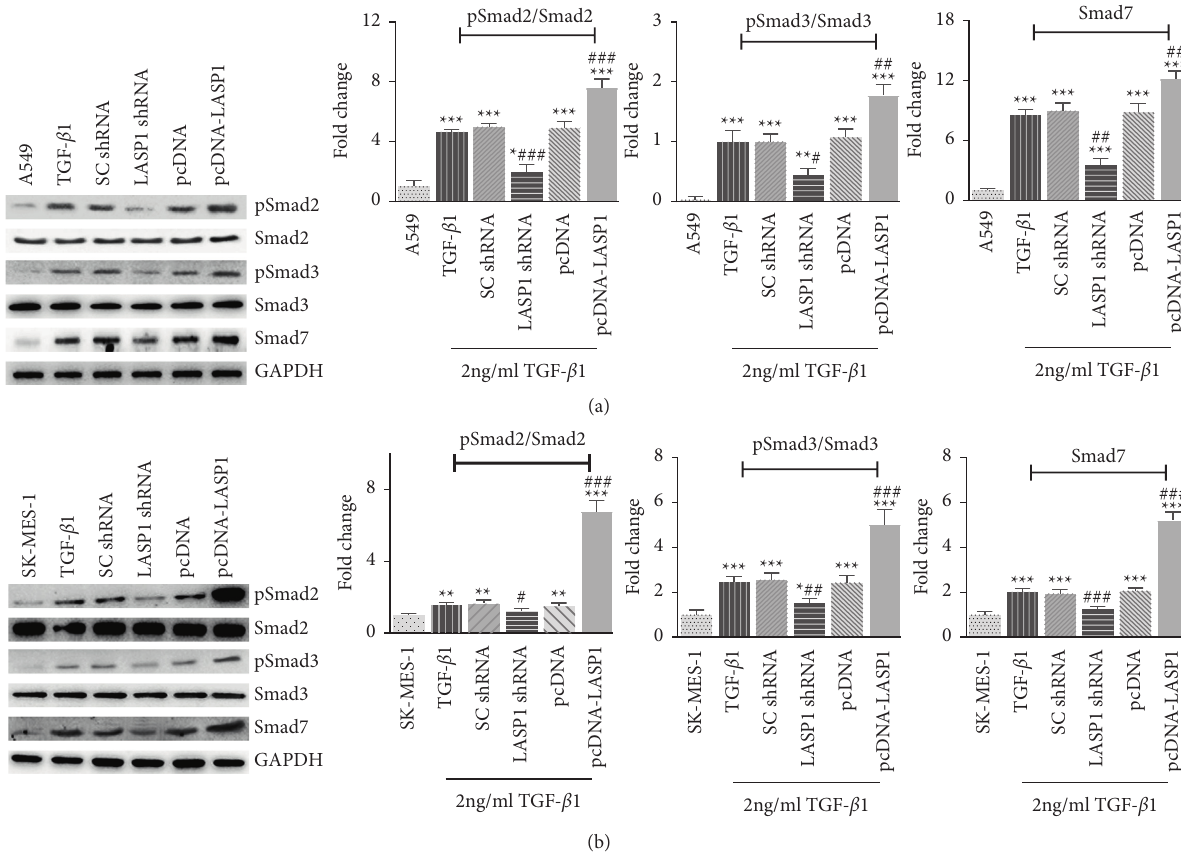
Figure 5: (a-b) LASP1 effect on key molecules in the TGF- β 1/Smad/Snail signaling pathway in A549 (a) and SK-MES-1 (b) cell lines under TGF- β 1 treatment. After 48 h coinfection with TGF- β 1 accompanying LASP1 knockdown or overexpression, the cell lysates were detected for protein levels of pSmad2, Smad2, pSmad3, Smad3, and Smad7 by western blot. Ratios of pSmad2/Smad2, pSmad3/Smad3 and Smad7/ GAPDH were presented by gray intensity analysis. GAPDH was used as reference control. Data were shown as mean ± SD, n � 3. ∗ p < 0 . 05, ∗∗ p < 0 . 01, and ∗∗∗ p < 0 . 001 vs. the cell alone group without TGF- β 1 treatment, and # p < 0 . 05, ## p < 0 . 01, and ### p < 0 . 001 vs. the TGF- β 1- treated noninfection group (TGF- β